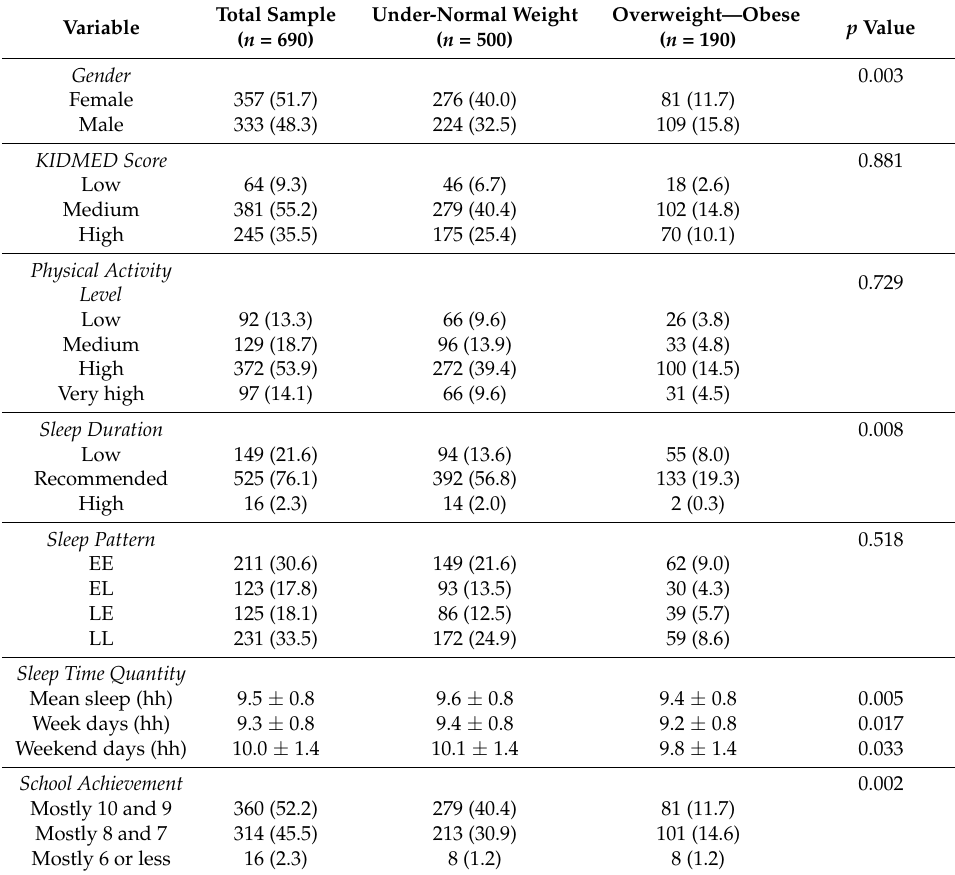
Table 2. Dietary habits, lifestyle, school achievement, and sleeping behaviors by